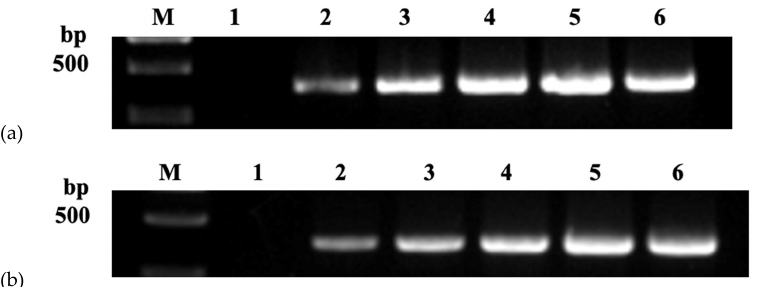
Figure 1. Optimization of diameter (a) and concentration (b) of nanoparticles: ( a ) Lane M, DL 2,000 Marker; Lane 1, negative control; Lanes 2–6, 10, 15, 20, 30, and 40 nm; ( b ) Lane M, DL 2,000 Marker; Lane 1, negative control; Lanes 2–6, 0.1, 0.2, 0.3, 0.4, and 0.5 mM.